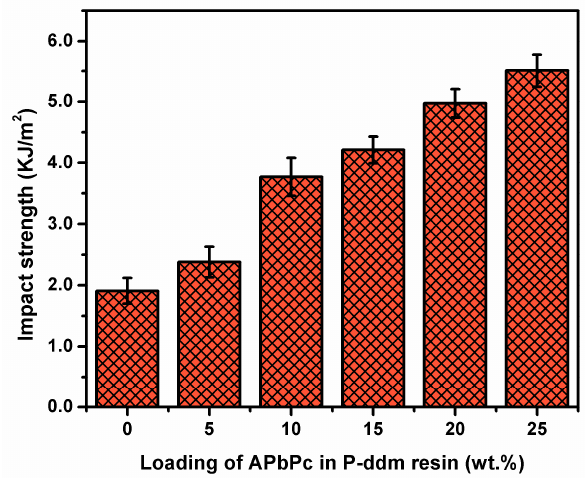
Figure 8. Impact strength of poly(P-ddm / APbPc) on various wt.% loading of APbPc.